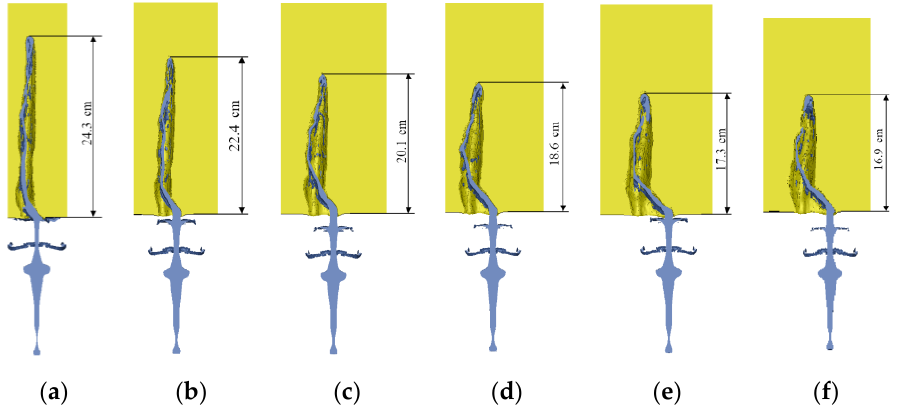
Figure 8. Penetration results at different target velocities: ( a ) v t = 150 m/s; ( b ) v t = 200 m/s; ( c ) v t = 250 m/s; ( d ) v t = 300 m/s; ( e ) v t = 350 m/s; ( f ) v t = 400 m/s.